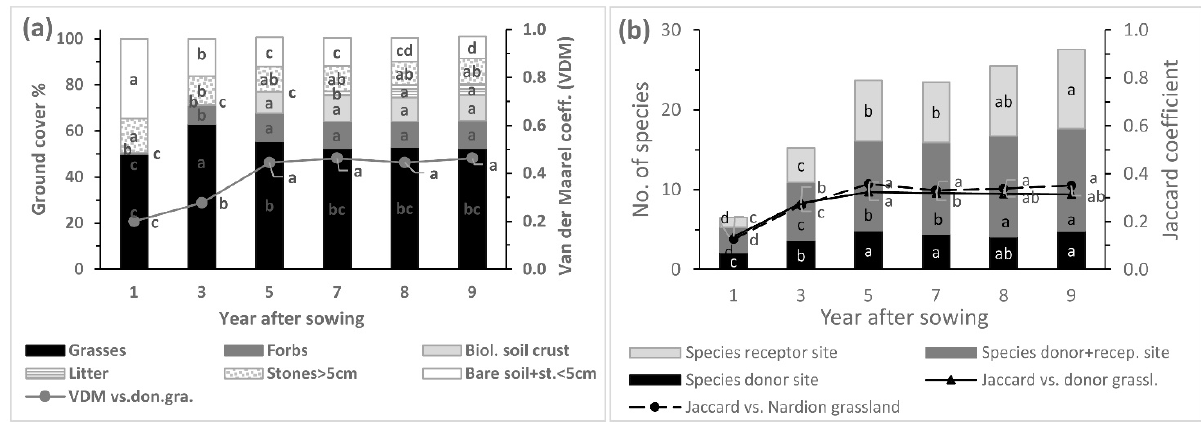
Figure 1. Time pattern of ground cover ( a ) and species number ( b ) at a ski slope grassland restoration experiment. Data are averages of twelve treatments (two fertilisation treatments × six propagation materials). VDM and Jaccard are the van der Maarel and Jaccard similarity indices, respectively. Letters show results of among-year comparisons.